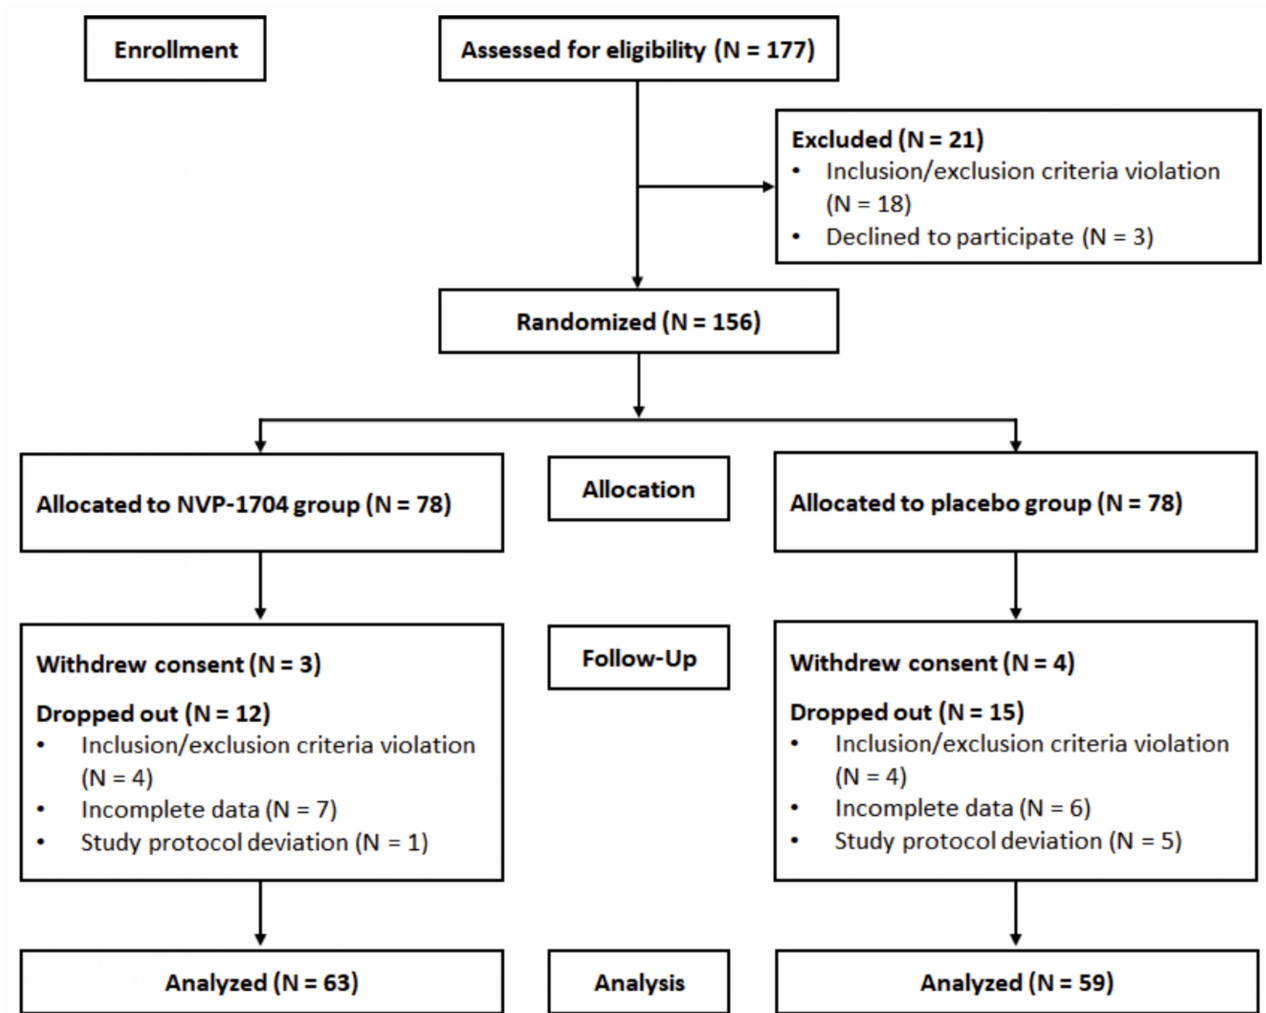
Figure 2. Flow chart of study